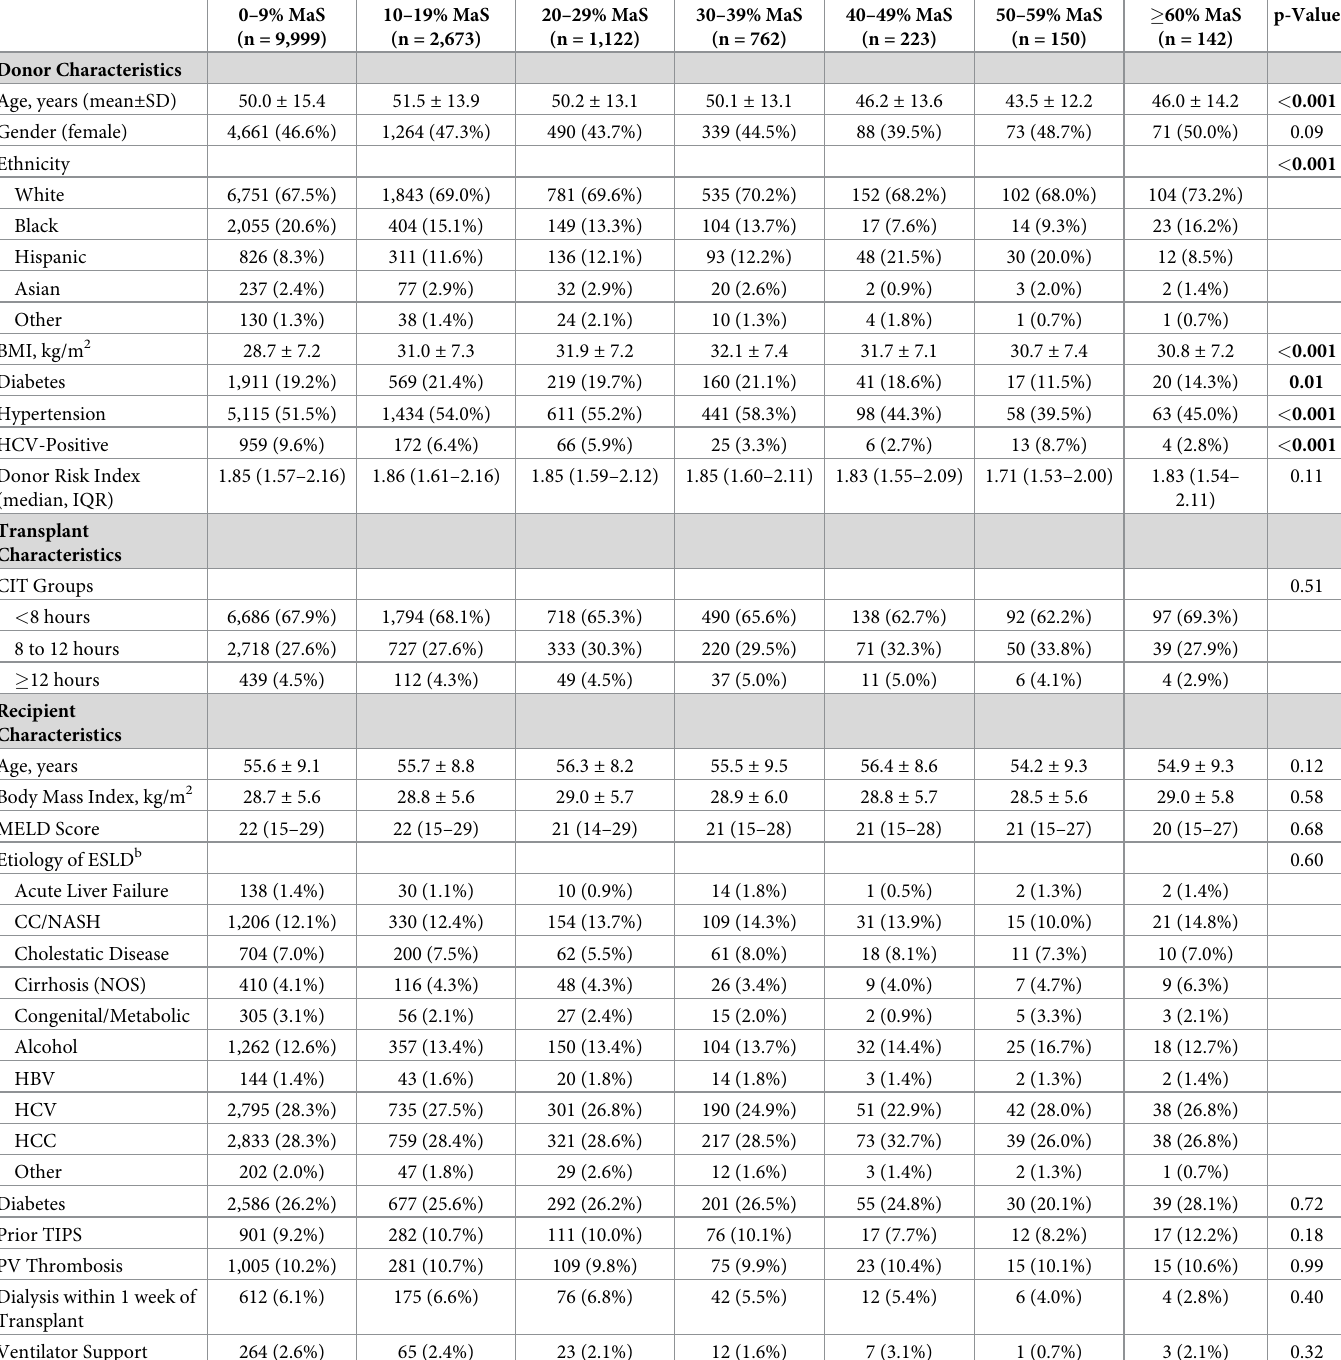
Table 2. Donor and recipient characteristics by donor biopsy MaS